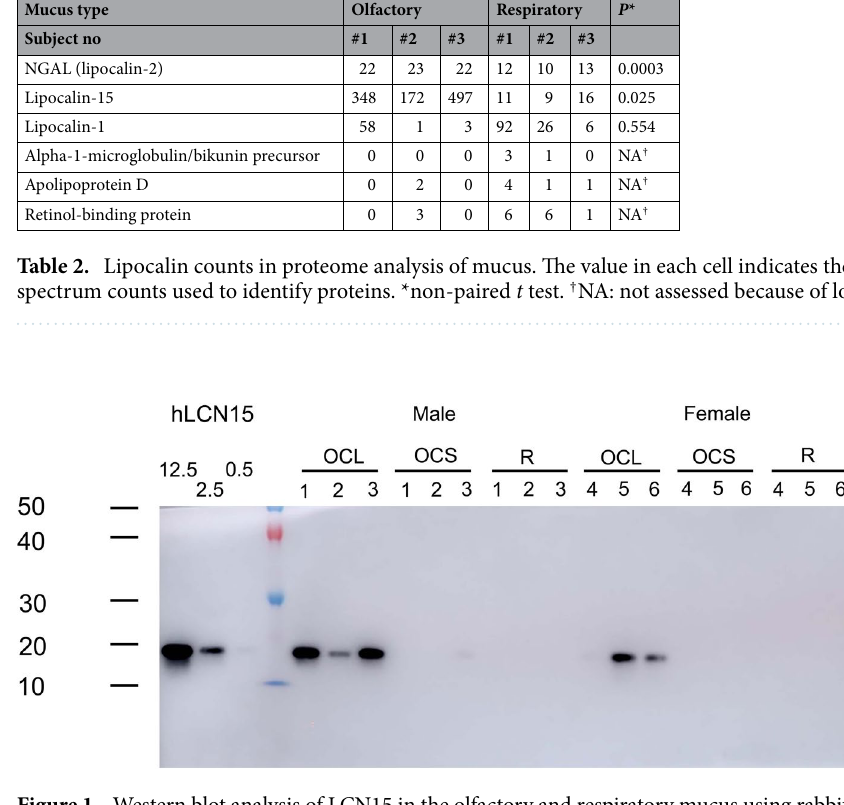
Figure 1. Western blot analysis of LCN15 in the olfactory and respiratory mucus using rabbit anti-LCN15 antibody. Respective immunoblots of samples of olfactory cleft lavage fluid (OCLF), olfactory cleft mucus collected by surgical sponge (OCMS) and respiratory mucus (R) from six participants with normal olfaction (3 males [No. 1–3] and 3 females [No. 4–6]). A mucus sample containing 1.82 μg protein was loaded in each lane. The three lanes in the left end show recombinant LCN15 protein (12.5, 2.5 and 0.5 ng/mL) as a positive